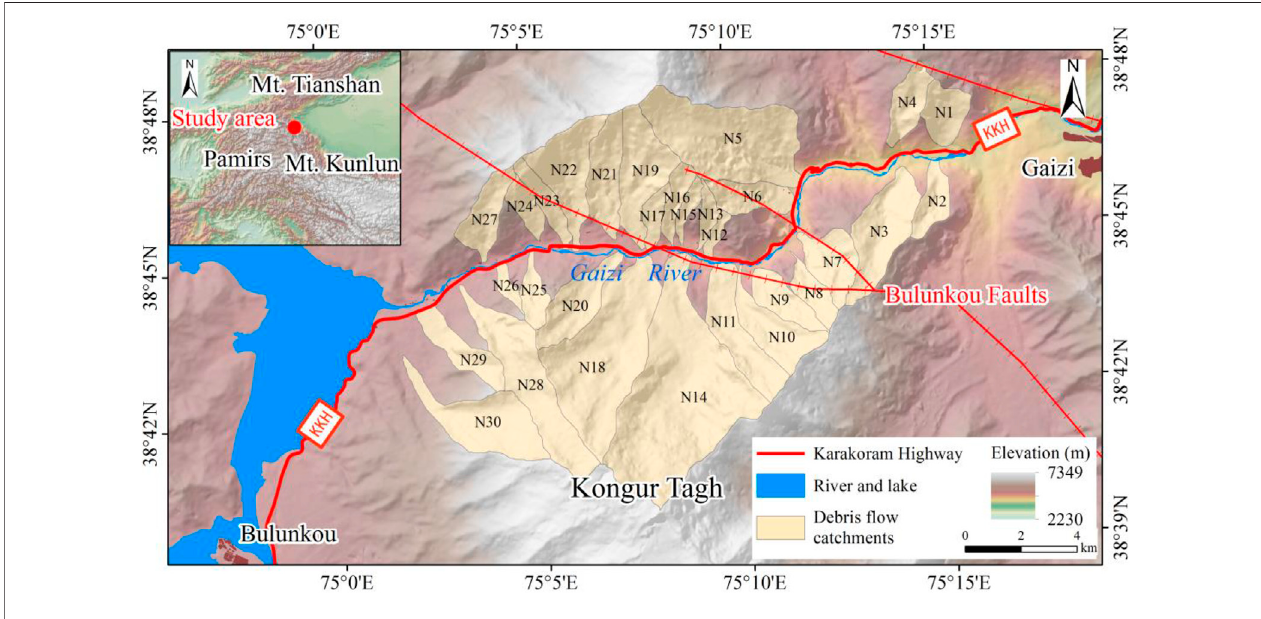
FIGURE 1 | Location of the study area and the debris fl ow catchments.